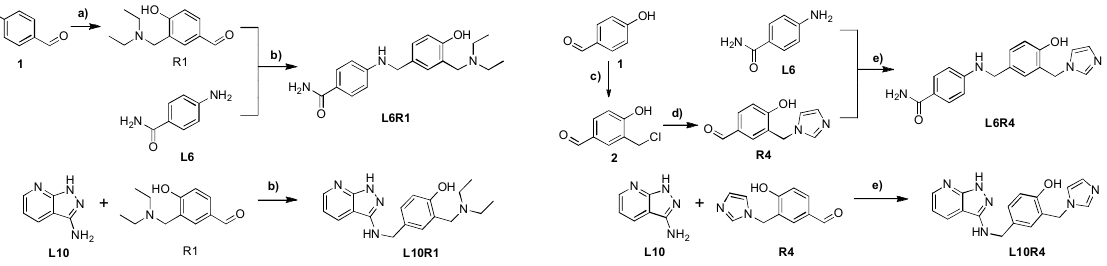
Figure 3. %Reactivation of non-oxime reactivators for VX and sarin inhibited hAChE. Figure 3. % Reactivation of non-oxime reactivators for VX and sarin inhibited Figure 3. % Reactivation of non-oxime reactivators for VX and sarin inhibited hAChE.